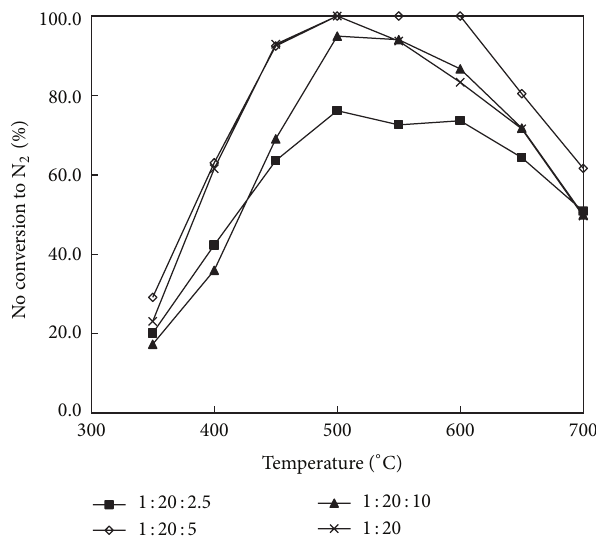
Figure 1: Conversion of NO to N 2 as a function of reaction temperatures over In(5%)/HZSM-5 and In/HZSM-5/In 2 O 3 with different In:HZSM-5: In 2 O 3 proportions. Feed gas: 2500 ppm NO, 2000 ppm CH 4 , 2.0% O 2, and balance of He; GHSV = 3600 h −1 .